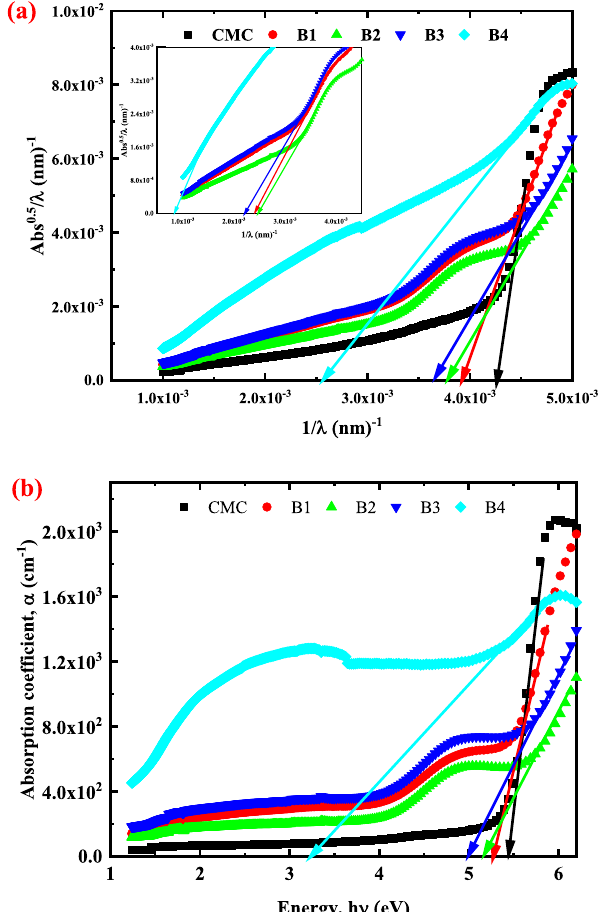
Figure 5. ( a ) Optical band gap determination using the ASF model for pure CMC and CMC loaded with different weight percentages of CuO-NPs and ( b ) Fluctuation in the absorption coefficient ( α) as a function of photon energy (hν) for CMC and CMC filled with 2, 4, 6 and 8 wt.% of CuO-NPs.